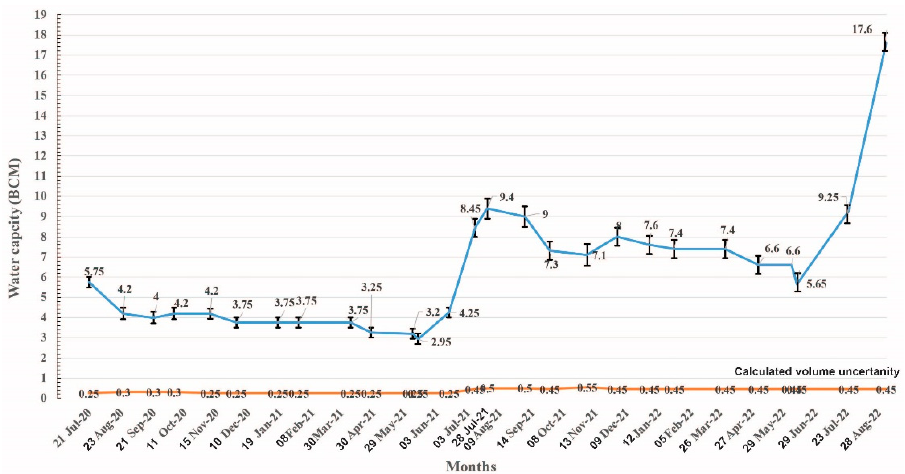
Figure 4. Chart showing the water volume capacity of the GERD Lake with the calculated volume uncertainty values in orange color from 21 July 2020 to 28 August 2022.